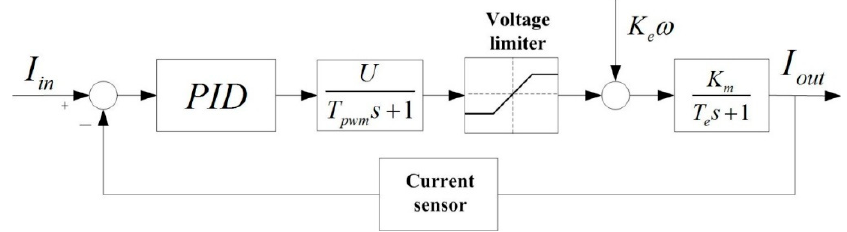
Figure 7. The structural diagram of current loop.